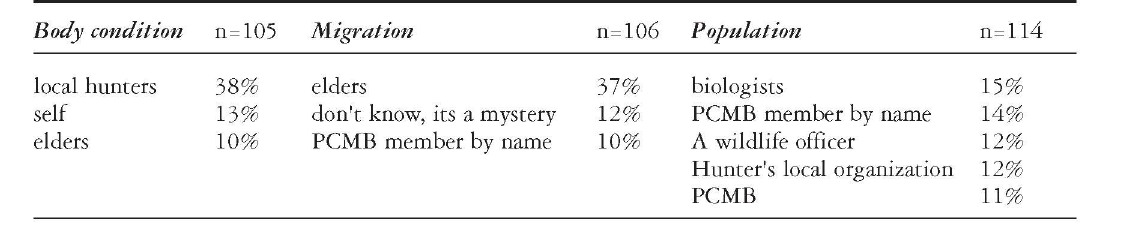
Table 1. What Old Crow, Fort McPherson, and Aklavik hunters perceive as the best source of information on body con dition, caribou migration, and the Porcupine herd's